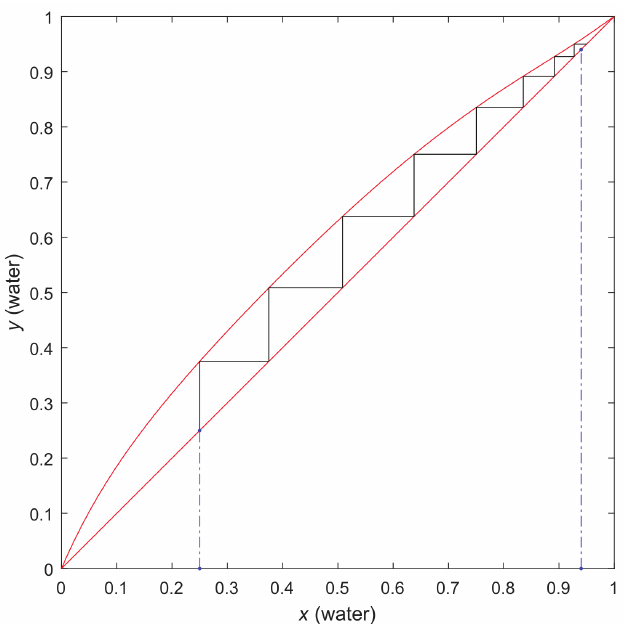
Fig. 5 – Illustration of the algorithm for NTP calculation us- ing example data (acetic acid-water mixture). In this case, the NTP value is